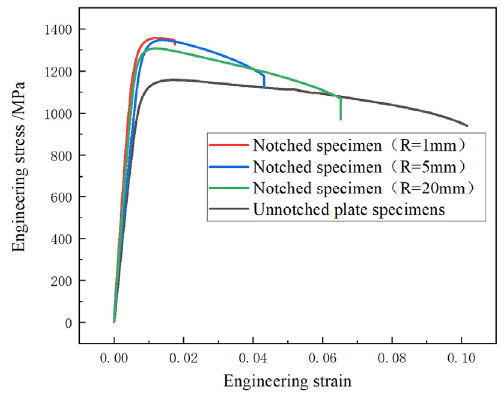
Figure 4. Tensile curve.